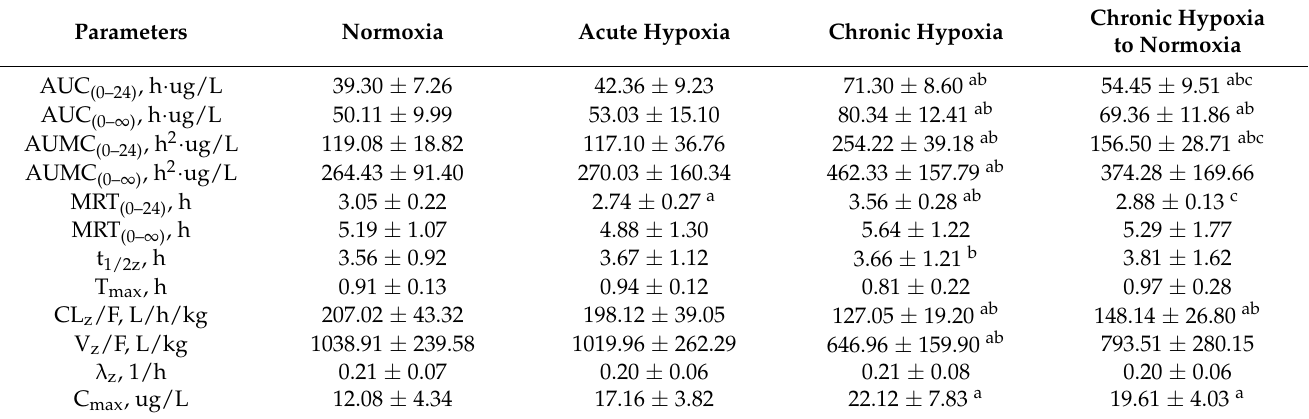
Table 4. Pharmacokinetic parameters of N-desmethyl sildenafil in rat plasma after exposure to high-altitude hypoxia.